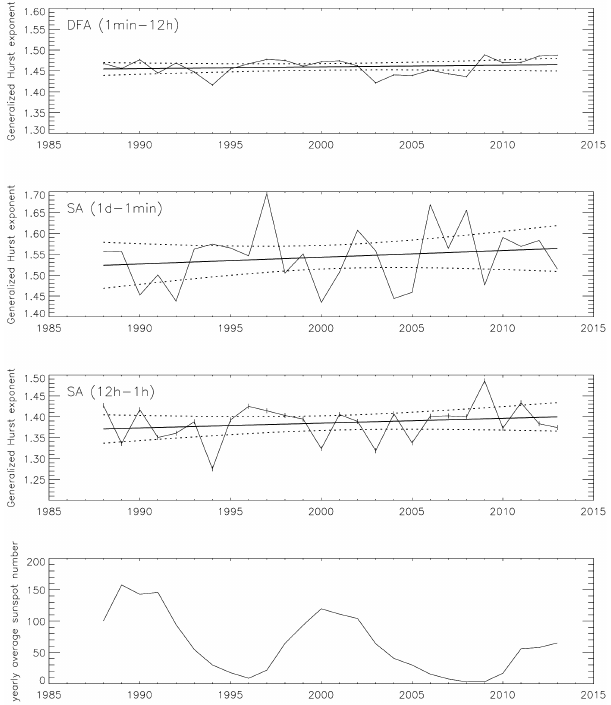
Figure 4. Generalized Hurst exponents ( β ) from all years 1988– 2013 (with uncertainties). Top panel: DFA method; second panel: SA method using the range of 1day–1min; third panel: SA using only 12–1h. Tentative linear trends are shown together with 95% confidence limits indicated by dotted hyperbolae. Bottom panel: yearly average sunspot